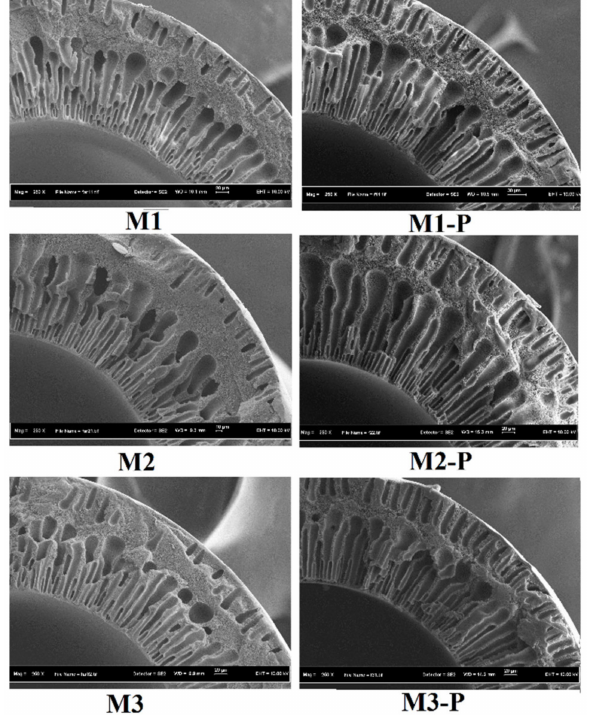
Figure 4. Cross-sectional images of side wall of non-post-treated ( M1 , M2 , and M3 ) and post-treated